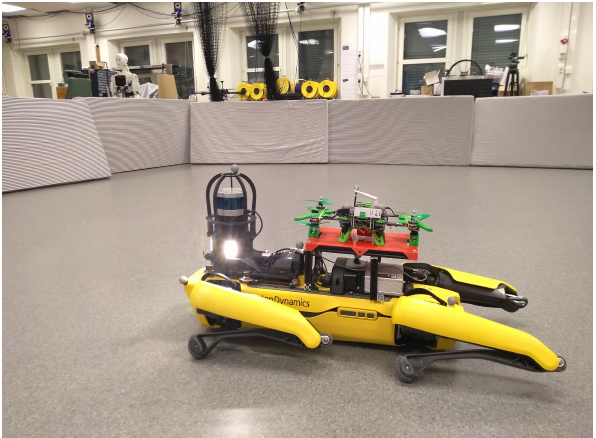
Figure 5. The legged-aerial explorer with the Boston Dynamics autonomy package and the R-shafter landing